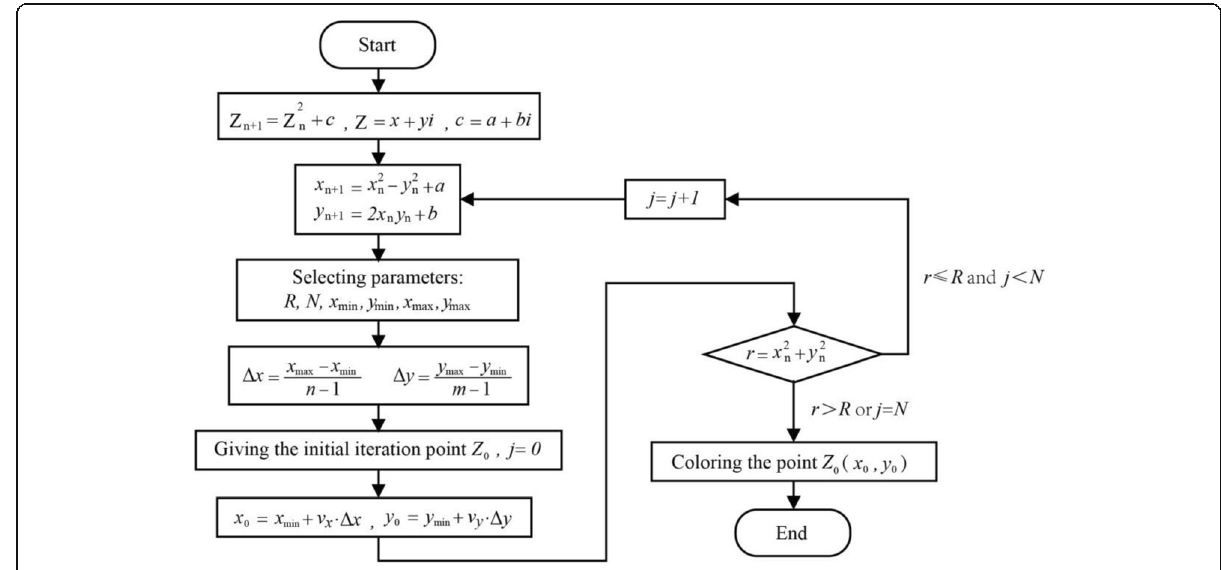
Fig. 3 Pattern design flow chart based on Julia